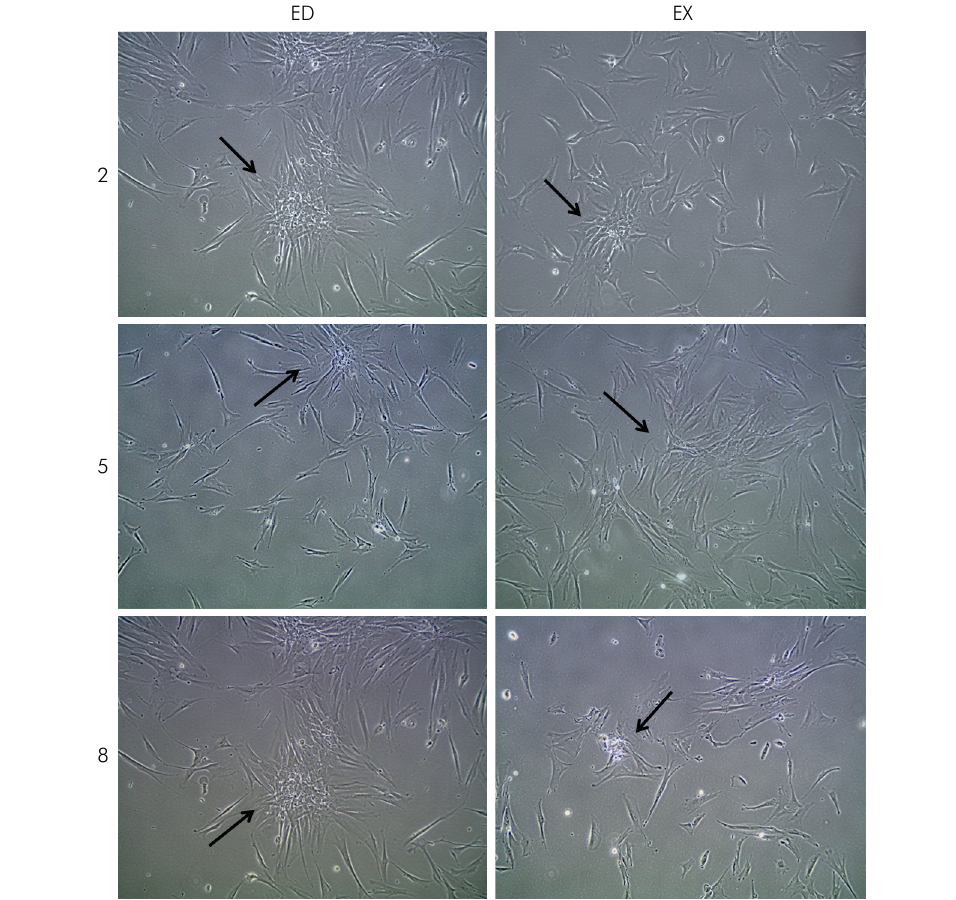
Figure 3. Inverted microscope images (20X) indicating dental pulp stem cells (DPSC)morphology and confluence, considering the techniques enzymatic digestion (ED) and explant (EX) and passages (2, 5 and 8), on the day after seeding. Arrows indicate multicellular nodules formation.